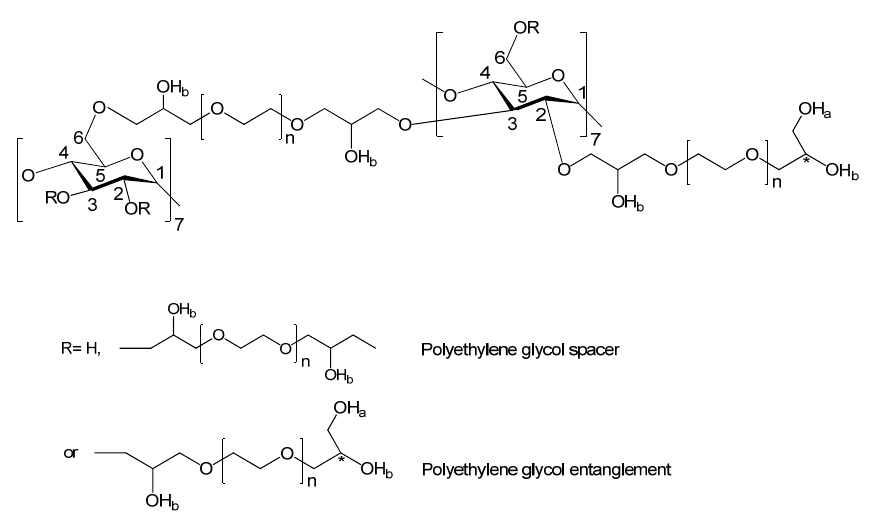
Figure 3. Proposed chemical structure of β CPCD polymer [16].